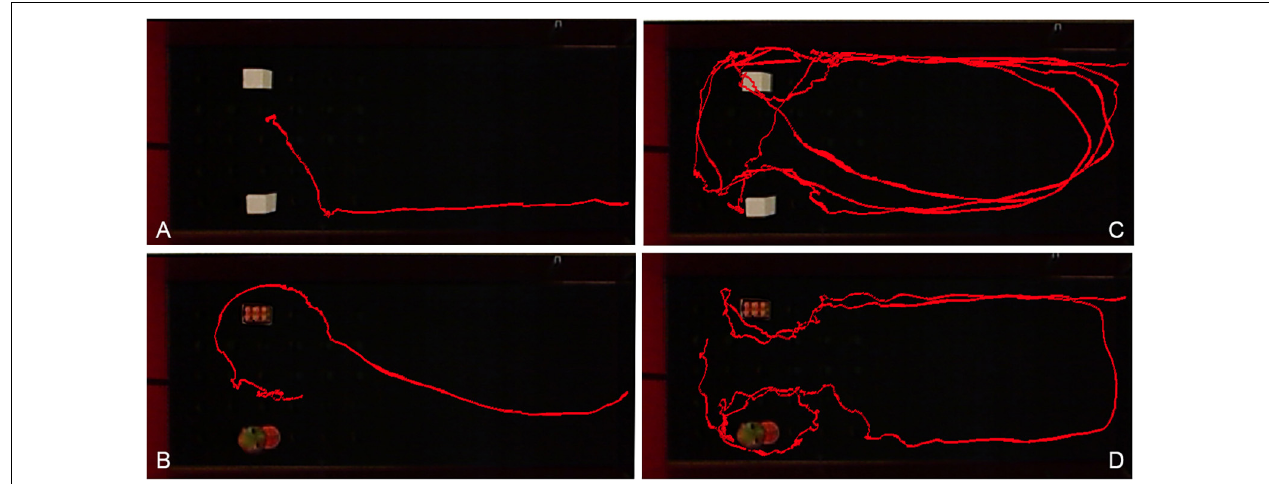
FIGURE 2 | Comparison of visual tracking examples of WT (A,B) and DAT-KO rats (C,D) during training with cubes (A,C) or novel objects (B,D) . WT, wild-type; DAT-KO, dopamine transporter knockout.